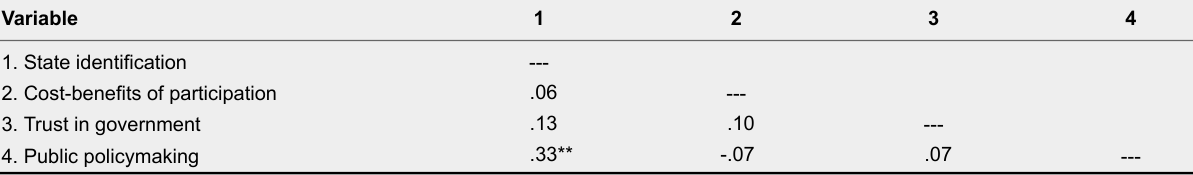
Study 2: Correlations Between Predictor and Dependent Variables